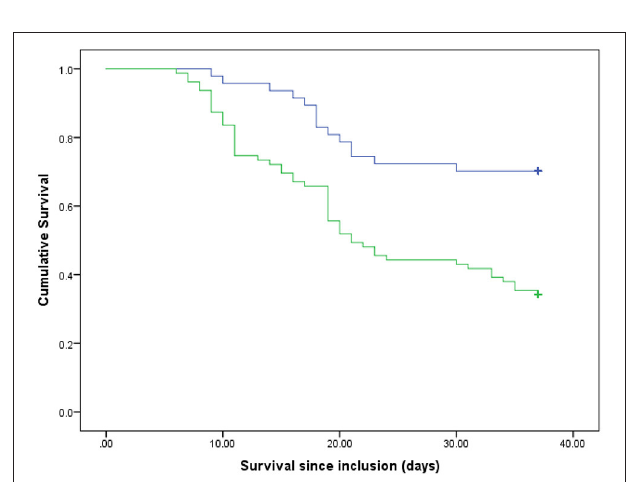
FIGURE 3 | Survival rates of the participants based on GLIM criteria. Blue line, well-nourished patients; green line, malnourished patients. p < 0.001 (log